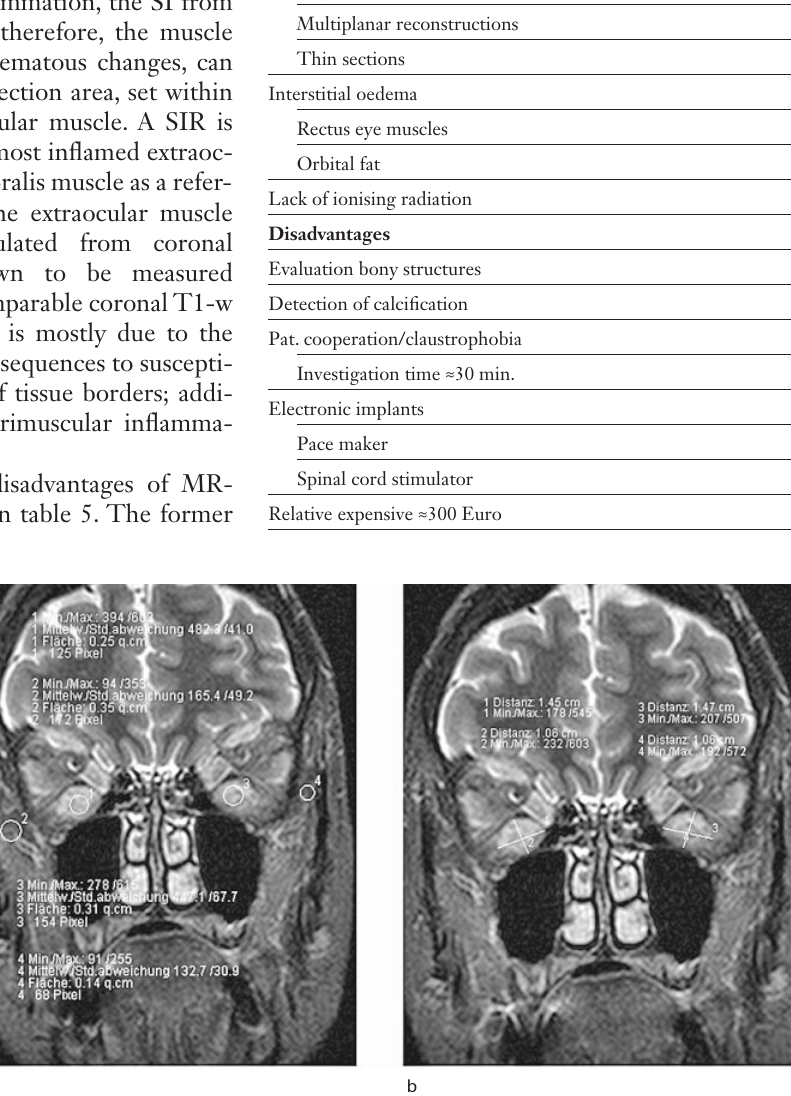
TransverseT1-w spin echo sequence of the orbit without contrast or fat saturation. Male patient with di- agnosis of clinically active Graves’ orbitopathy (G.Ch., 1942). Lipomatous and fibrous changes of the left lateral rectus muscle, as a sign of long standing disease (arrow). Marked bilat- eral exophthalmos; Hertel index right: 24 mm, left: 27